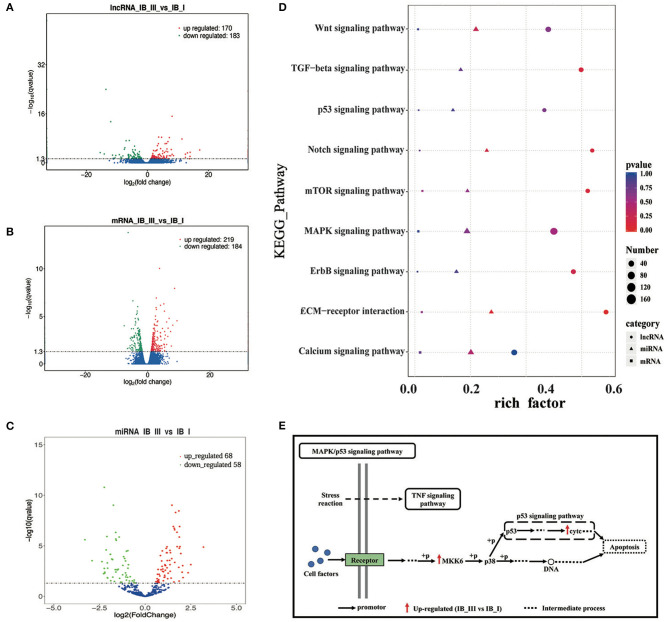
The analysis of differential expression and KEGG enrichment of lncRNA, mRNA, and miRNA in IB_I and IB_III. (A–C) Volcano map of differentially expressed lncRNA, mRNA, and miRNA. (D) The KEGG pathways enriched by lncRNA, mRNAand miRNA, relating to bone development. The color and size of shape represent p-value and enrichment numbers, respectively; the circle, triangle and square represent lncRNA, mRNAand miRNA, respectively. (E) The schematic diagram of MAPK/p53 signaling pathway. The black arrow represents the promotor; the red arrow represents the up-regulated (IB_III vs IB_I); the dotted line represents the intermediate process.